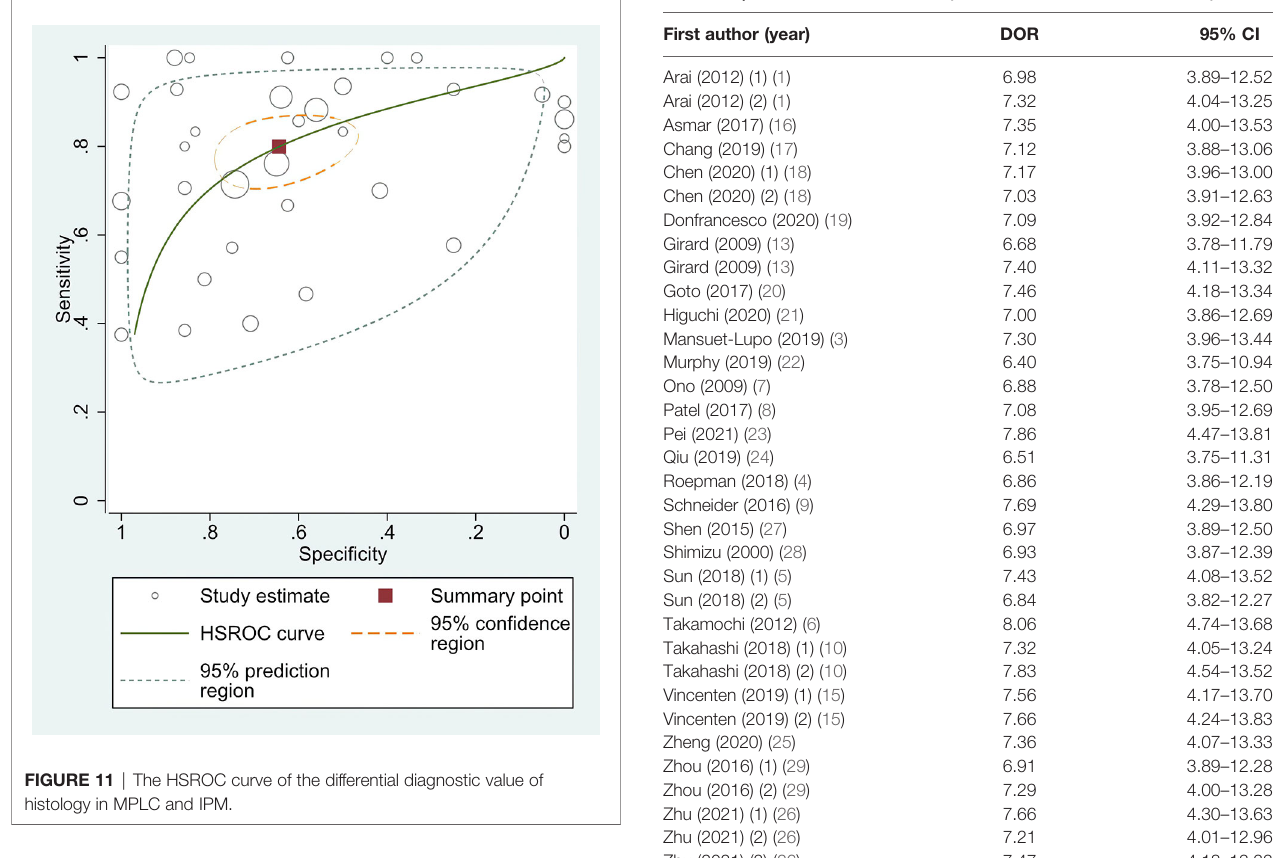
TABLE 4 | The in fl uence of each study on the outcome of the